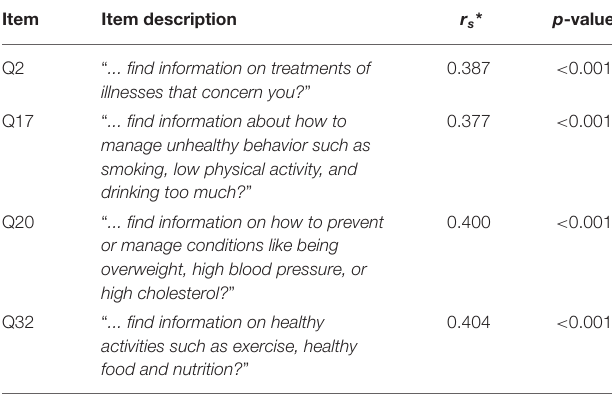
TABLE 3 | Analysis of the strongest correlations between MHL and single items of the HL 47 .